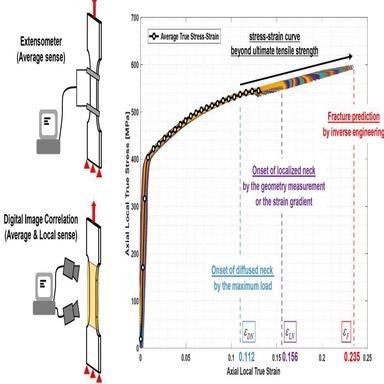
A tensile stress-strain curve of AA 2024-T3 beyond uniform deformation.